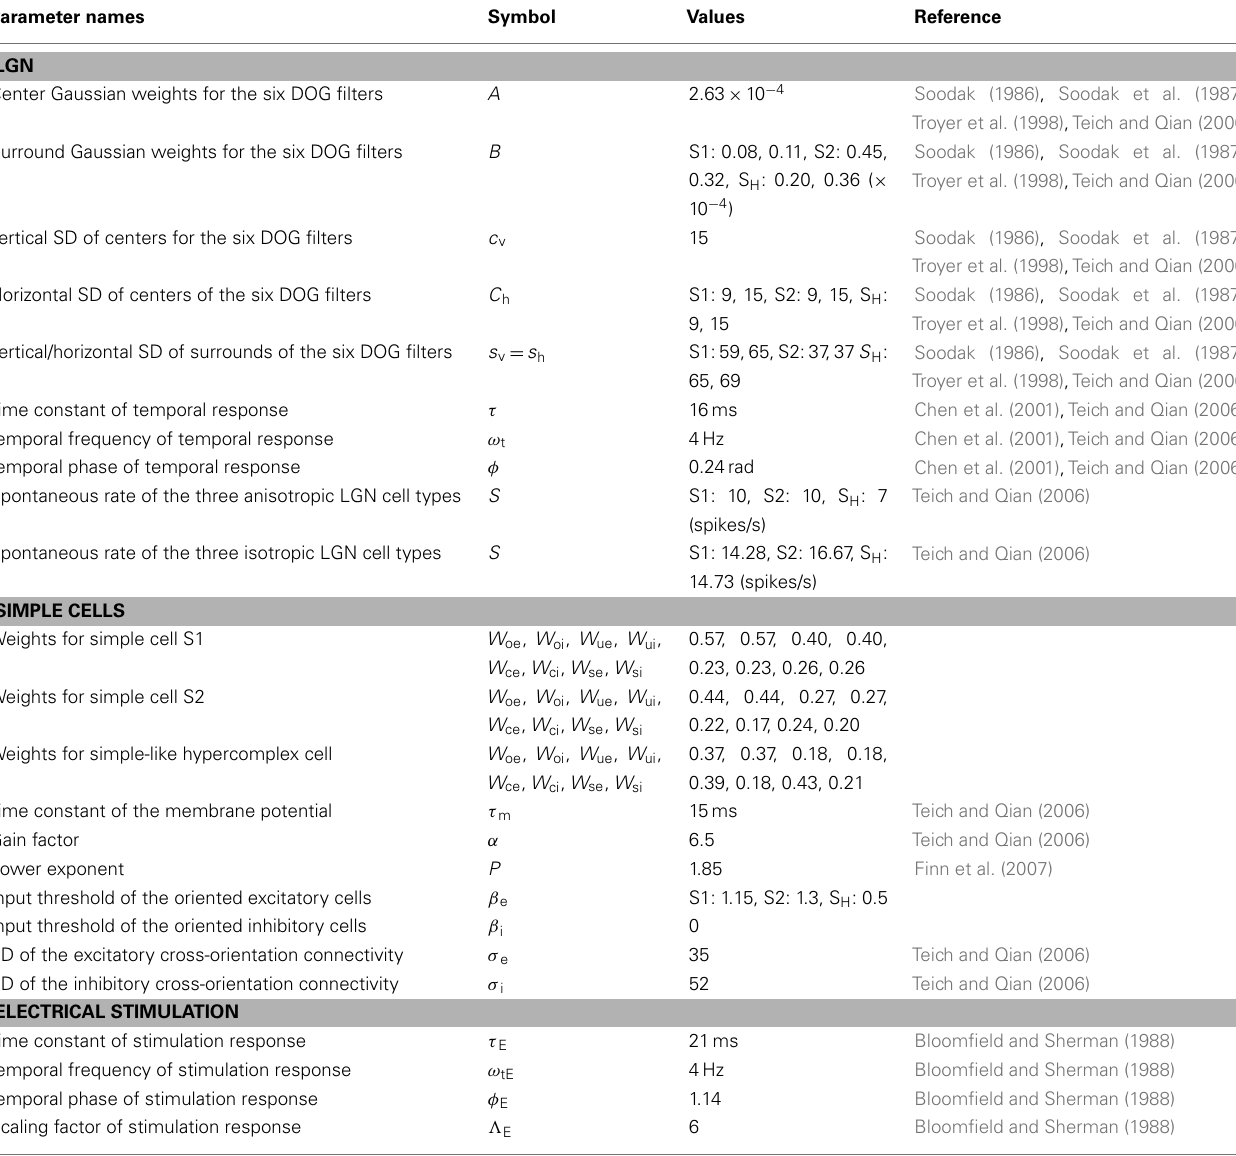
Table 1 | Model parameter names, symbols, values, and